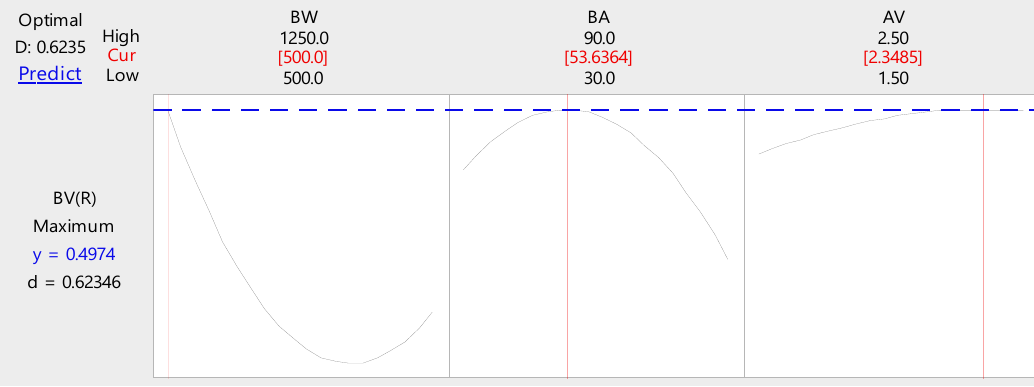
Figure 12. Statistical analysis plots of bed weight, blade angle, and air velocity.